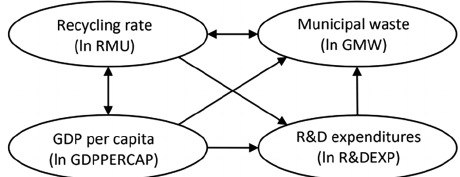
Figure 2. Statistically significant causality